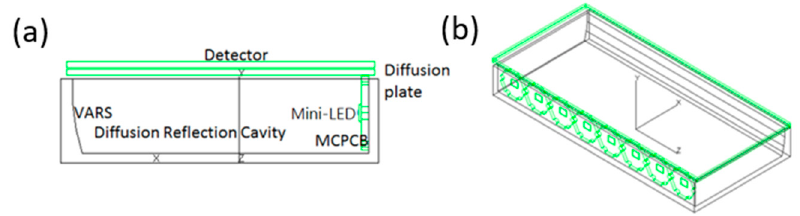
Figure 10. Hollow light guide with VARS: ( a ) side view and ( b ) isometric view.